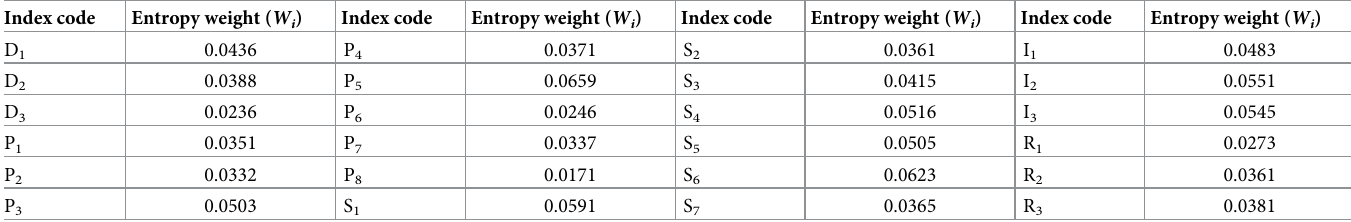
Table 9. Entropy weight of each